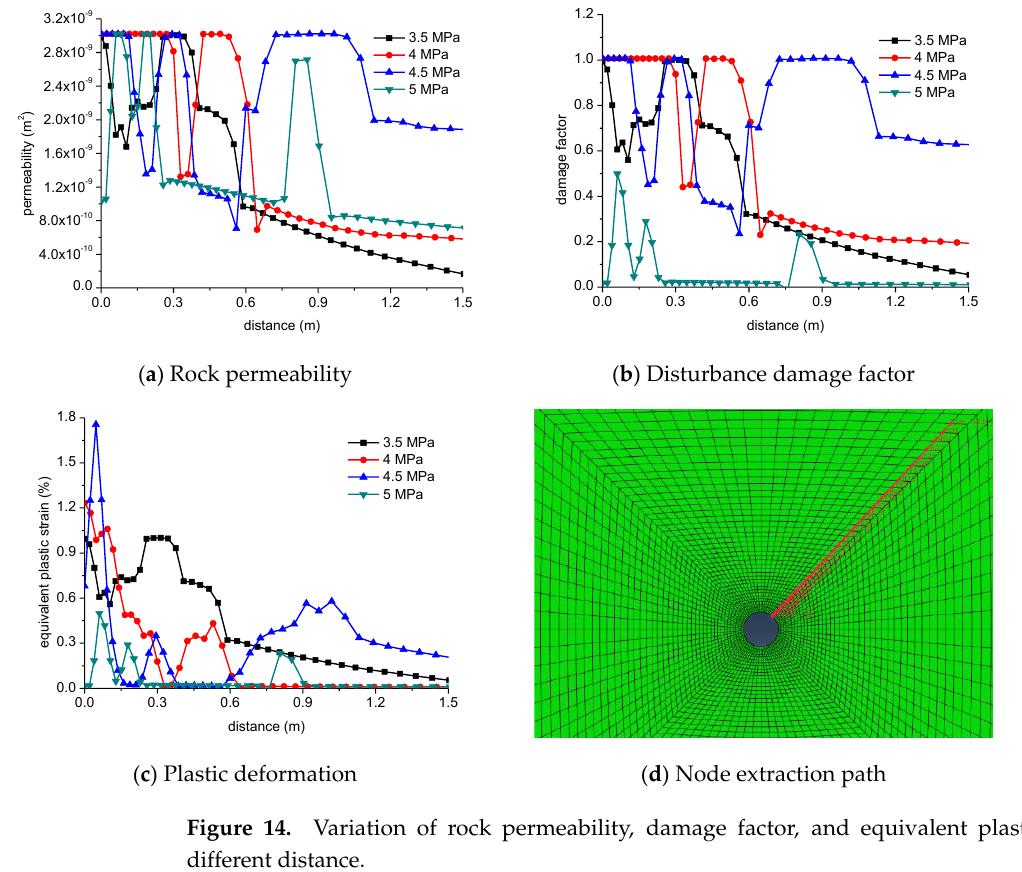
Figure 14. Variation of rock permeability, damage factor, and equivalent plastic strain with different distance.